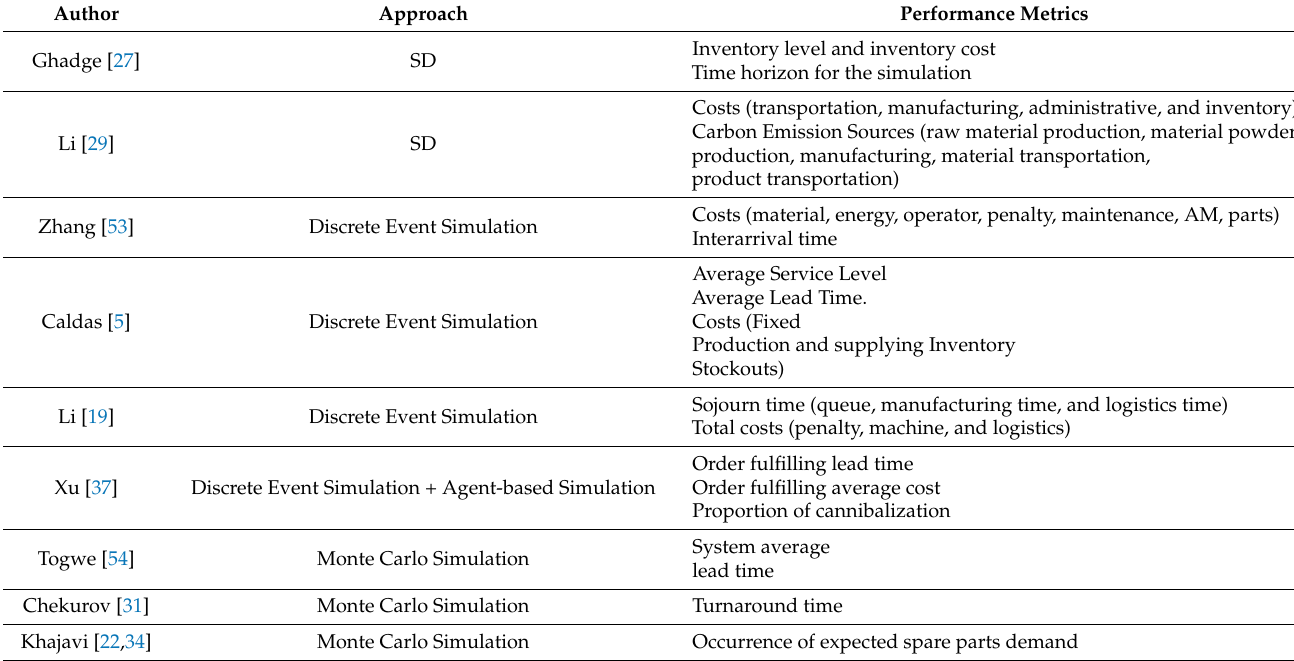
Table 4. Approaches and Performance metrics for simulation